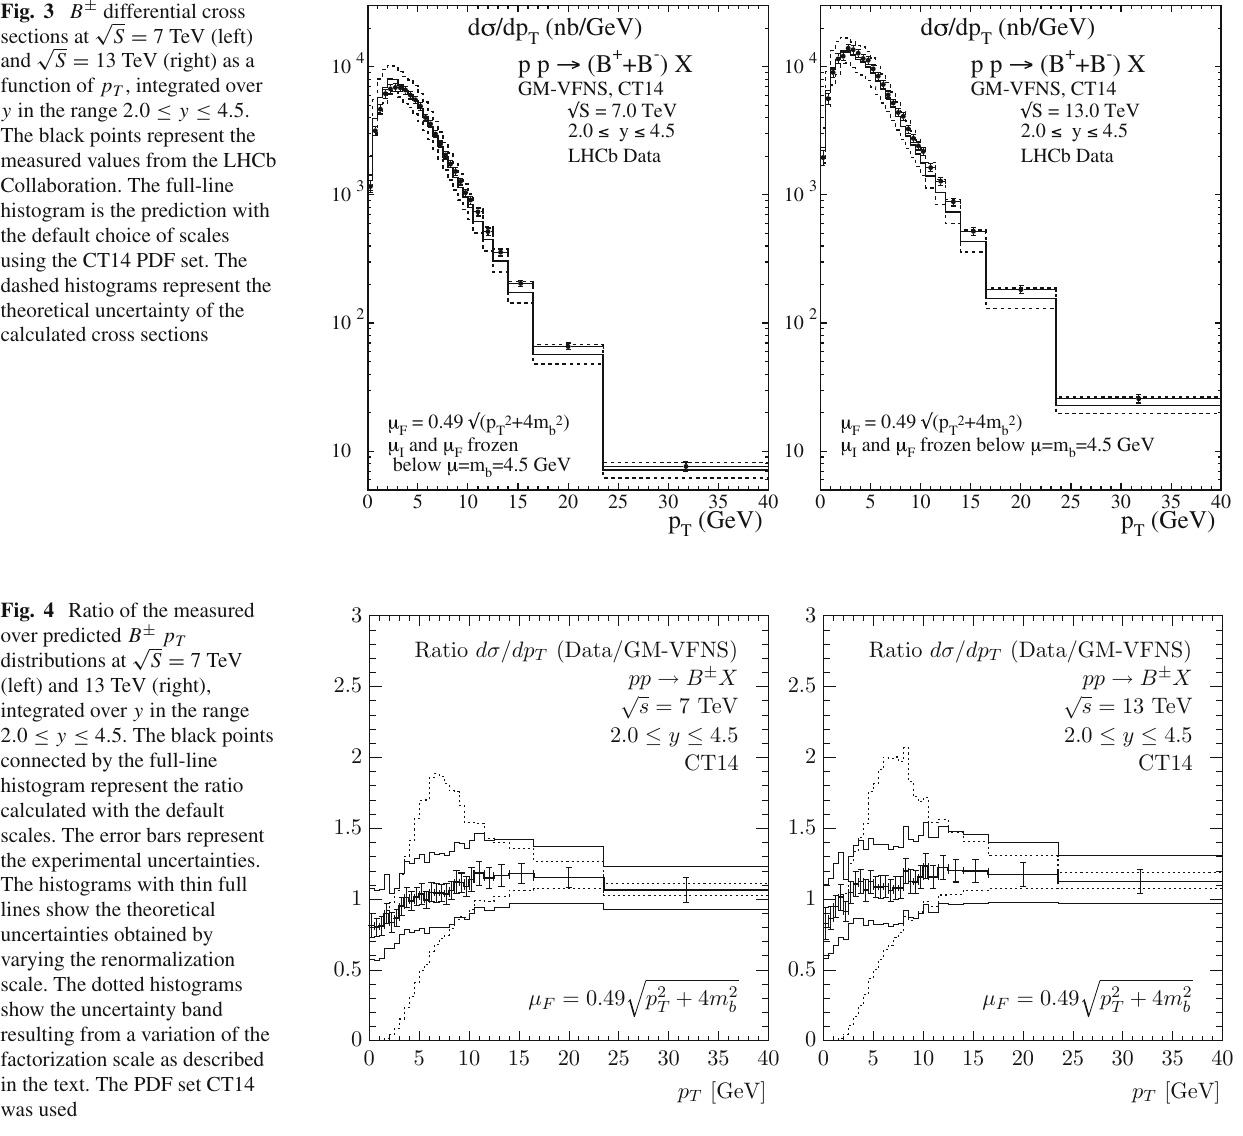
Fig. 3 B ± differential cross √ S = 7 TeV (left) sections at √ S = 13 TeV (right) as a and function of p T , integrated over y in the range 2 . 0 ≤ y ≤ 4 . 5. The black points represent the measured values from the LHCb Collaboration. The full-line histogram is the prediction with the default choice of scales using the CT14 PDF set. The dashed histograms represent the theoretical uncertainty of the calculated cross sections